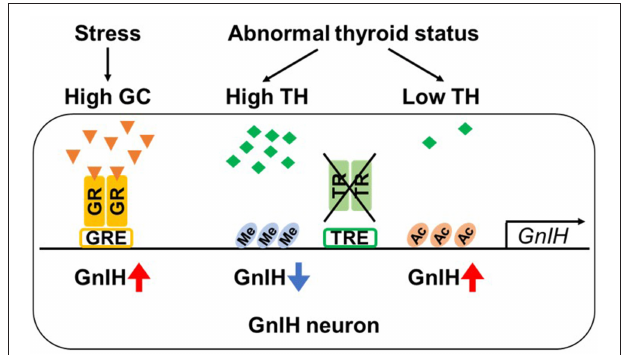
FIGURE 2 | Regulation of GnIH promoter activity by glucocorticoid and thyroid hormone. GnIH expression is regulated by glucocorticoid (GC). GnIH neurons express GC receptor (GR) and GC-response element (GRE) is present in GnIH promoter region. Stress increases GC levels, and GC acts by binding to GR. When GC-bound GR is recruited to GRE, GnIH expression is up-regulated. GnIH expression is also actively changed by concentration of thyroid hormone (TH). Although GnIH neurons express TH receptors (TR α and β ) and putative TH-response elements (TREs) exist in GnIH promoter region, TRs do not directly bind to GnIH promoter. However, thyroid status highly regulates the chromatin modification of GnIH promoter. Hypothyroidism exhibits increased GnIH expression with hyperacetylation of H3 (Ac) in promoter region. On the other hand, hyperthyroidism decreases GnIH expression associated with H3K9tri-methylation